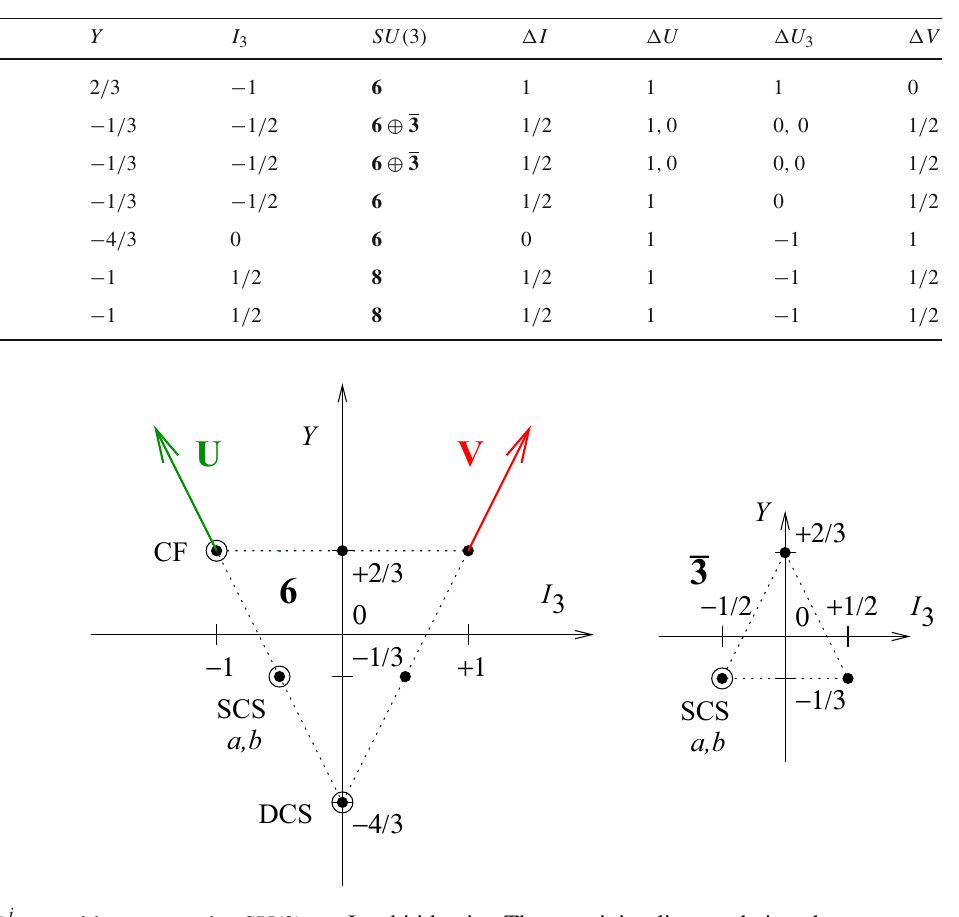
Table 2 SU(3) and SU(2) properties of the effective (cid:2) C = 1 and (cid:2) C = 0 Hamiltonian H eff ( O − ) in Eq. (8), represented in flavor space by the